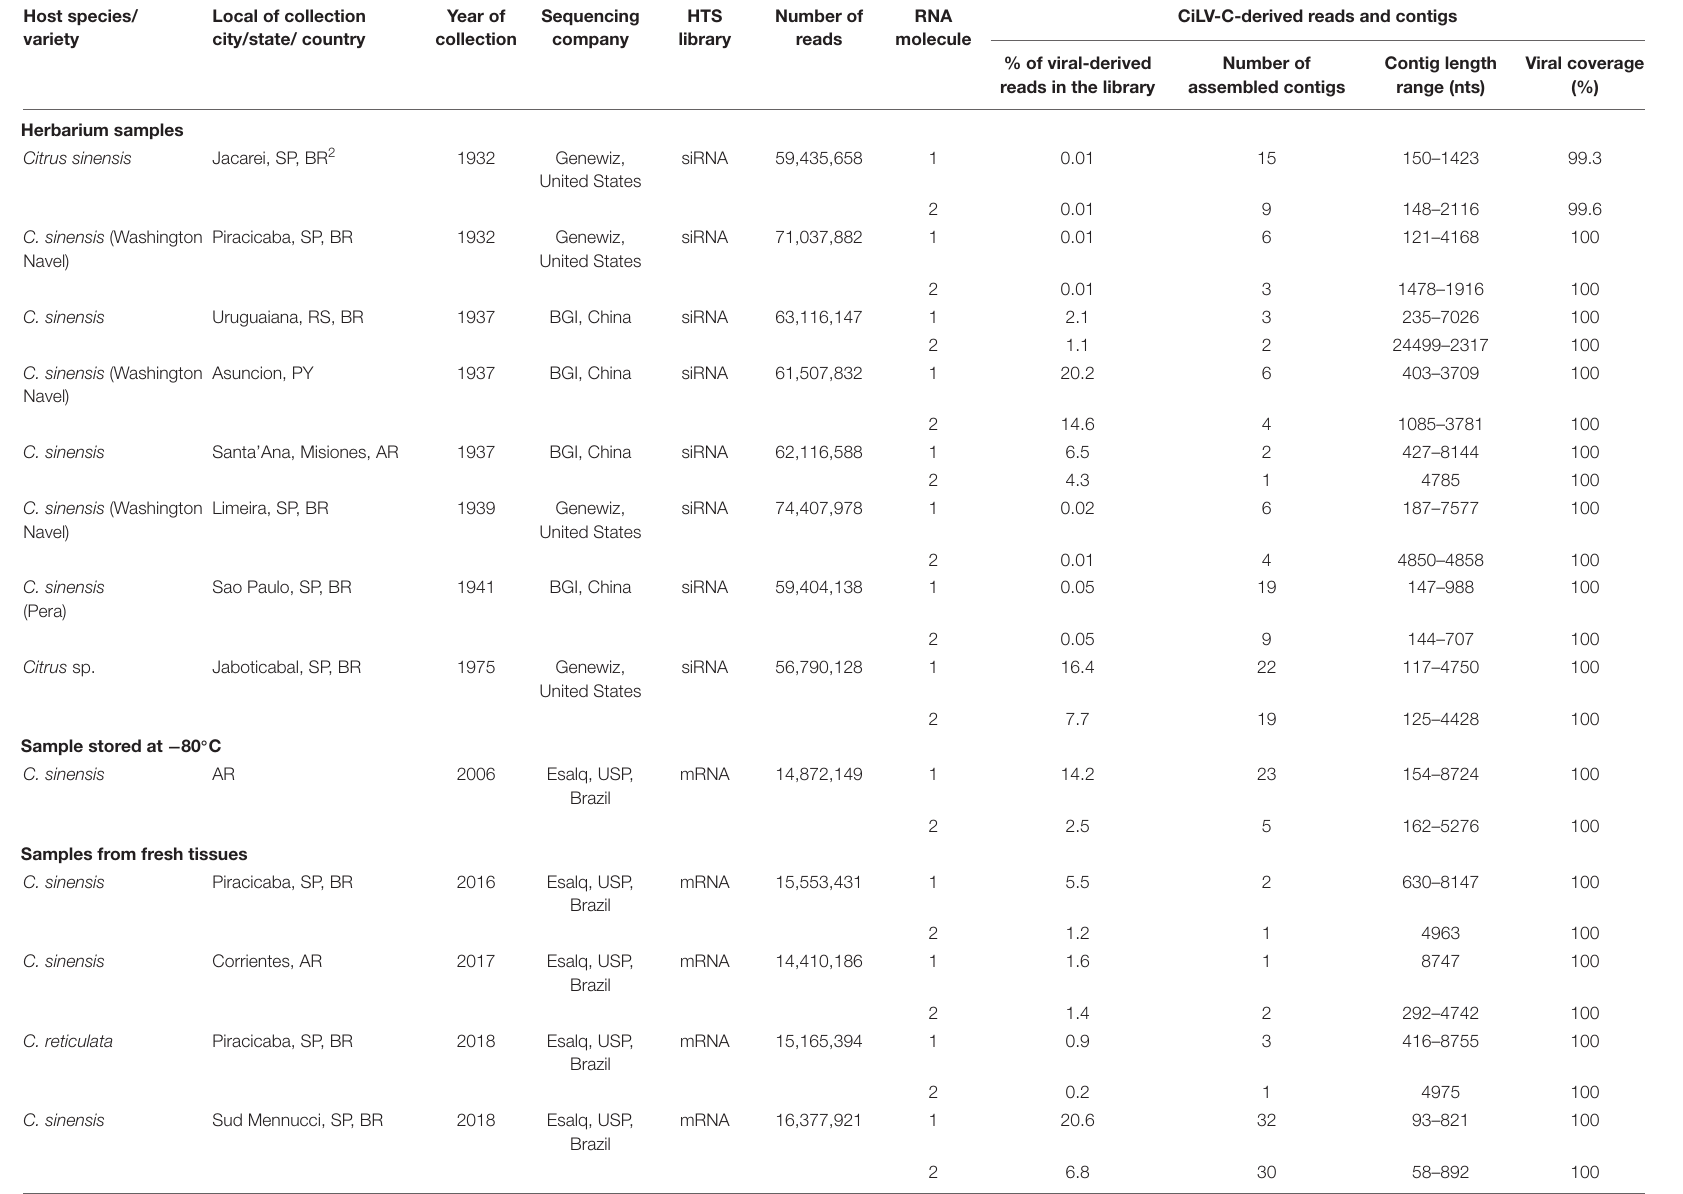
TABLE 3 | Brief description of the 18 high-throughput sequencing (HTS) libraries obtained in this